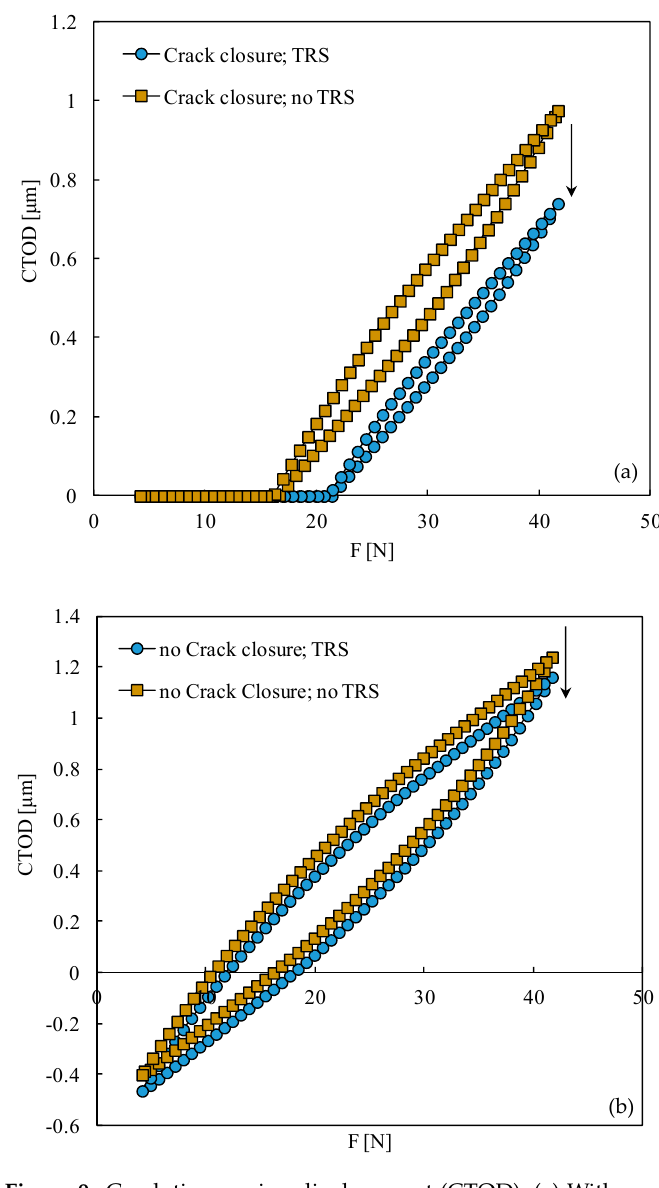
Figure 9. Crack tip opening displacement (CTOD). ( a ) With contact of crack flanks. ( b ) Without contact of crack flanks (a = 17.876 mm).